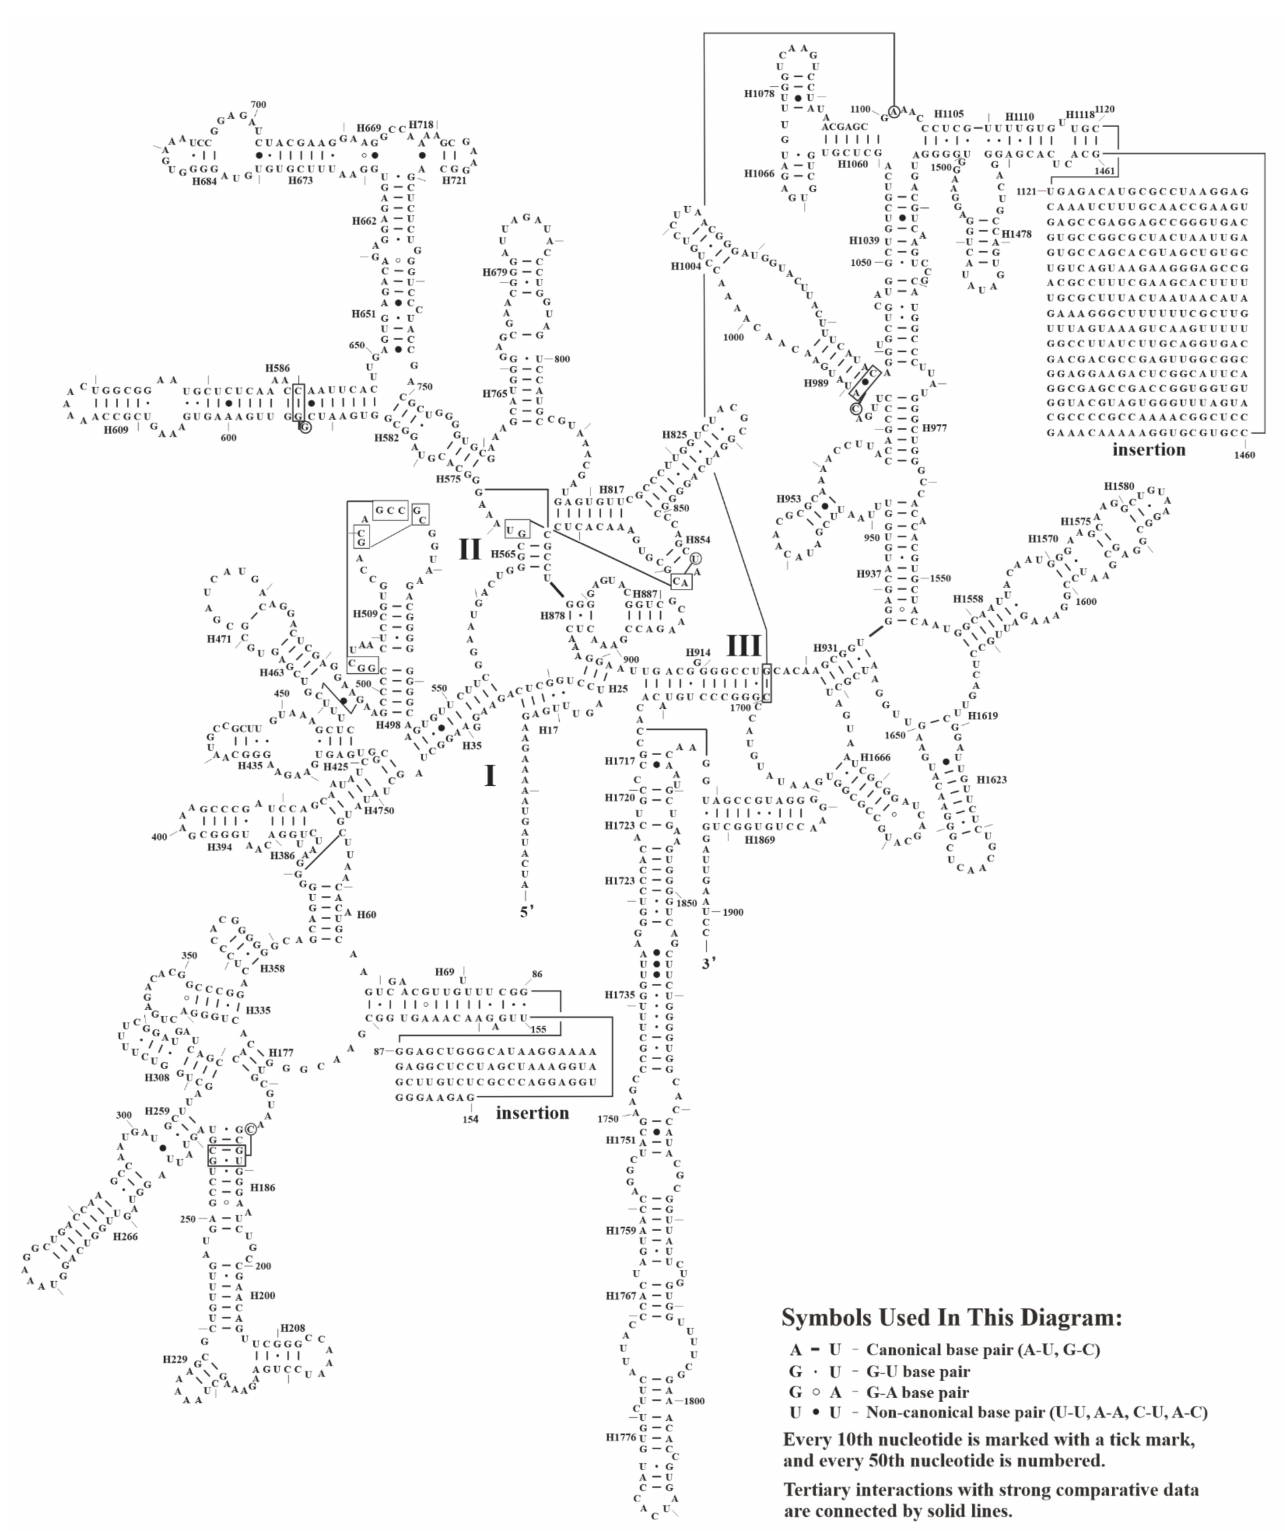
Figure 8. The predicted secondary structure of 18S mtrRNA of S. plumbizincicola